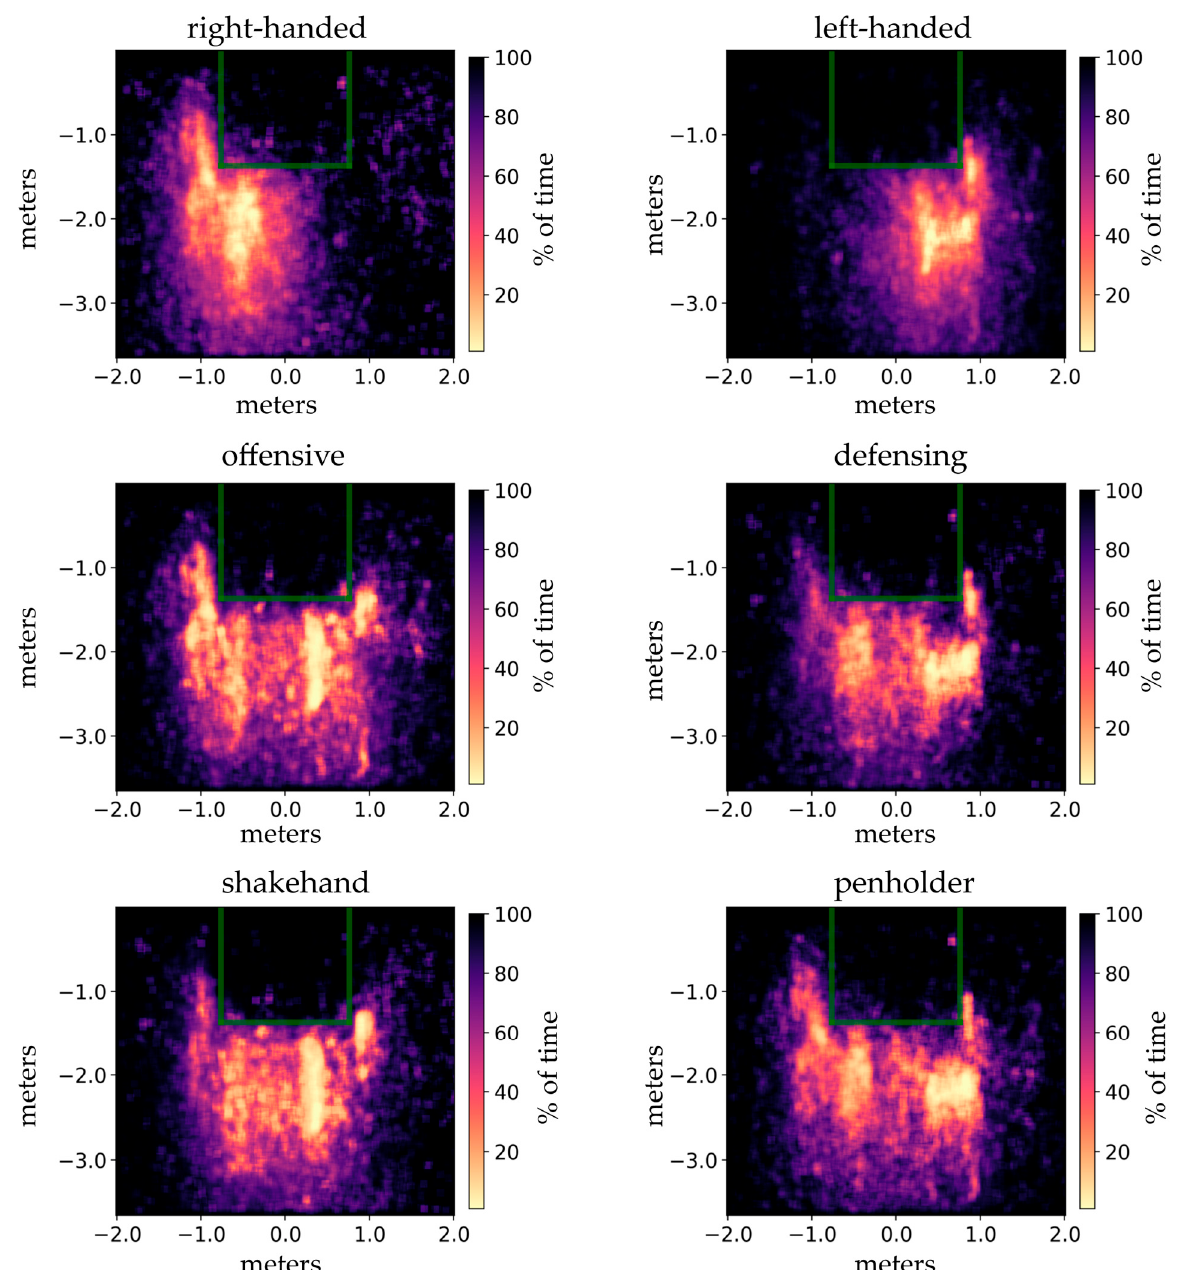
Figure 3. Heatmap comparison for the player types differentiated for right- vs. left-handed players, offensive vs. defensive players and shakehand vs. penholder grip players. For example, a purple color (purple = 60%) indicates that the player had been in the area (purple or lighter) 60% of the time. The lighter the color (light yellow), the more often the players had been in that area.